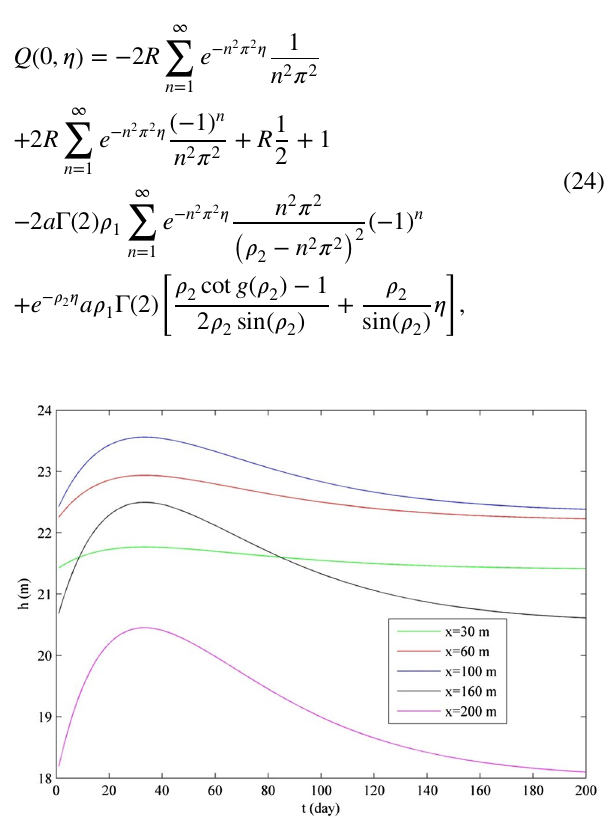
Fig. 5 Profile of groundwater hydraulic head versus time at different points of the aquifer